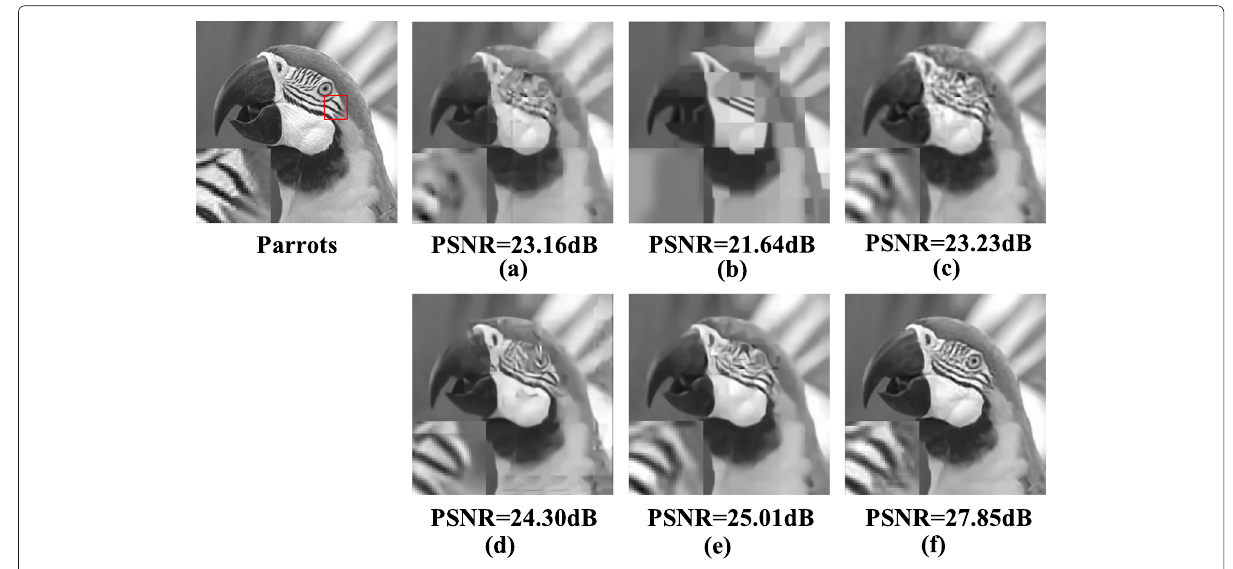
Fig. 6 The reconstruction results of Parrots at the measurement rate of 0.1 with BM3D. a TVAL3. b DAMP. c ReconNet. d DR 2 -Net. e CSRNet. f